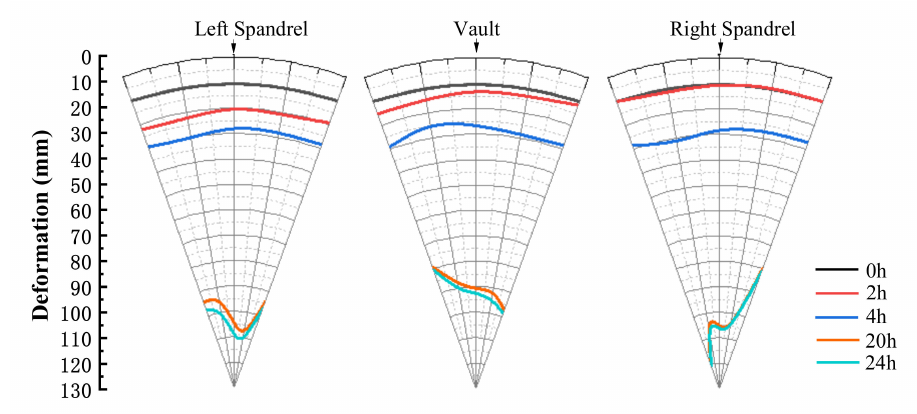
Figure 13. Evolution diagram of deformation amount at each representative